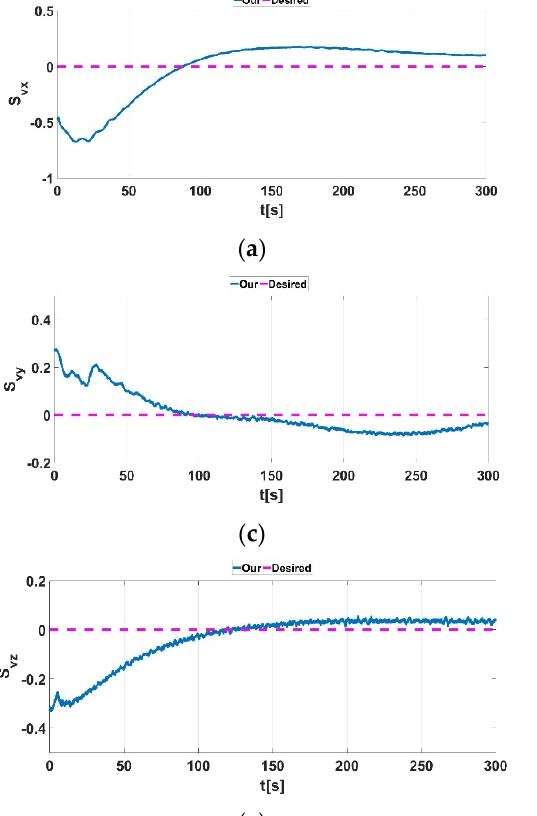
Figure 14. Inner − loop PID sliding surface 𝑺 𝑃𝐼𝐷 . ( a ) 𝑆 𝑥 ; ( b ) 𝑆 𝜑 ; ( c ) 𝑆 𝑦 ; ( d ) 𝑆 𝜃 ; ( e ) 𝑆 𝑧 ; ( f ) 𝑆 𝜓 .